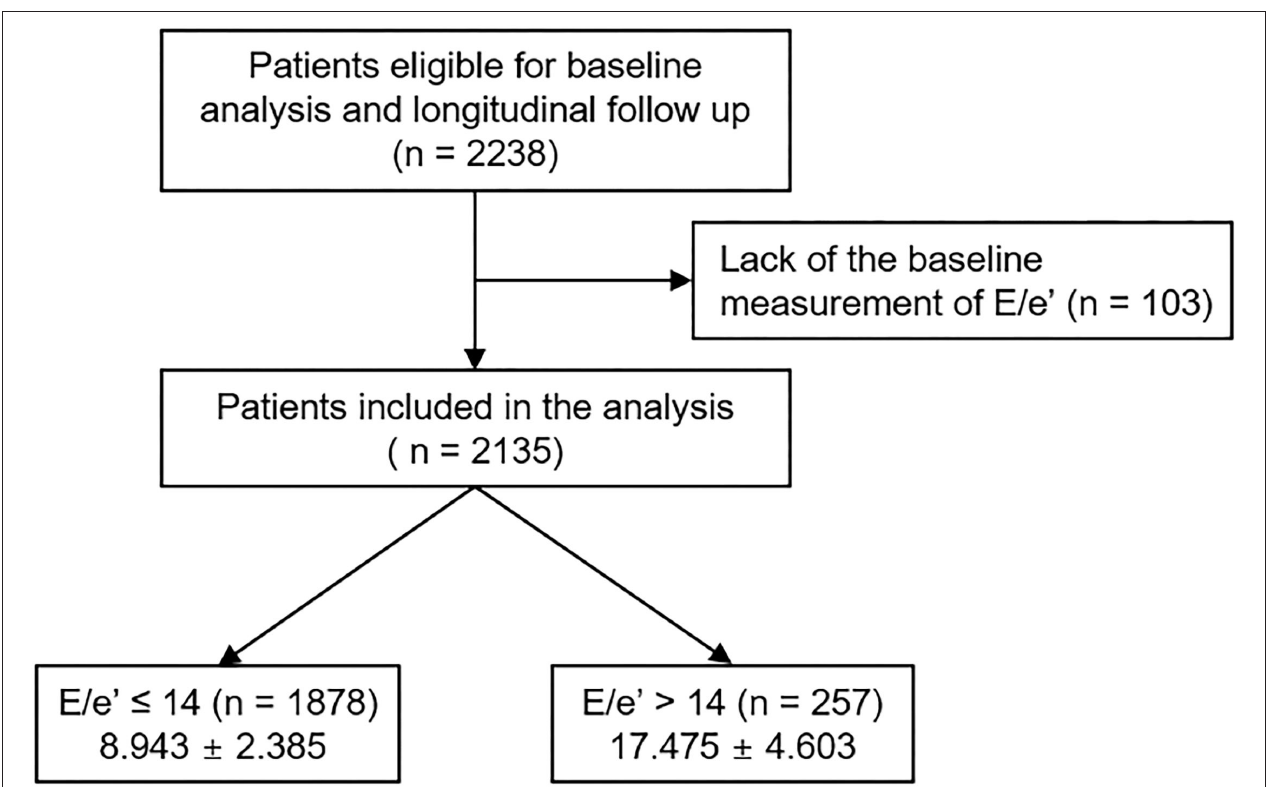
FIGURE 1 | Flow diagram of the study participants. E / e ′ , ratio of the early transmitral blood flow velocity to early diastolic velocity of the mitral